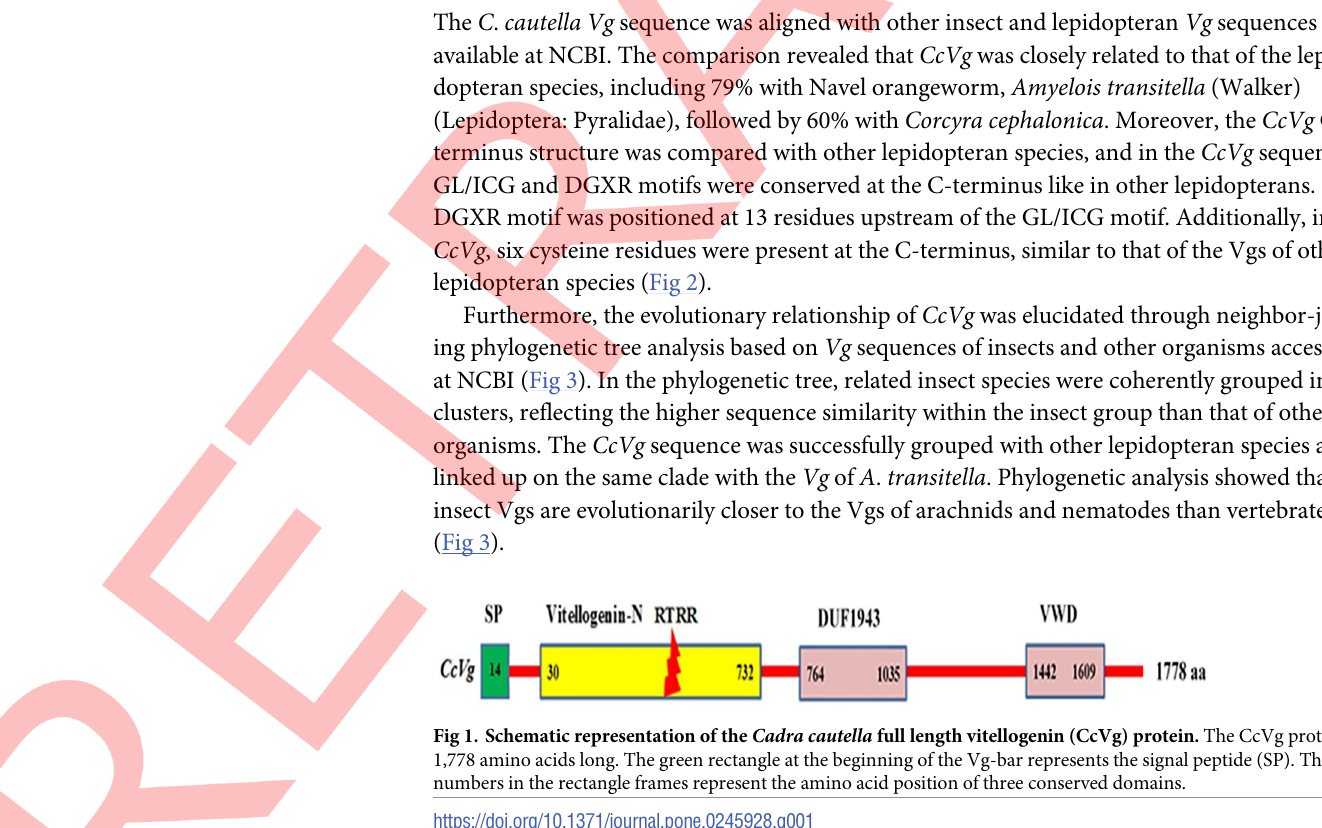
Fig 1. Schematic representation of the Cadra cautella full length vitellogenin (CcVg) protein. The CcVg protein is 1,778 amino acids long. The green rectangle at the beginning of the Vg-bar represents the signal peptide (SP). The numbers in the rectangle frames represent the amino acid position of three conserved